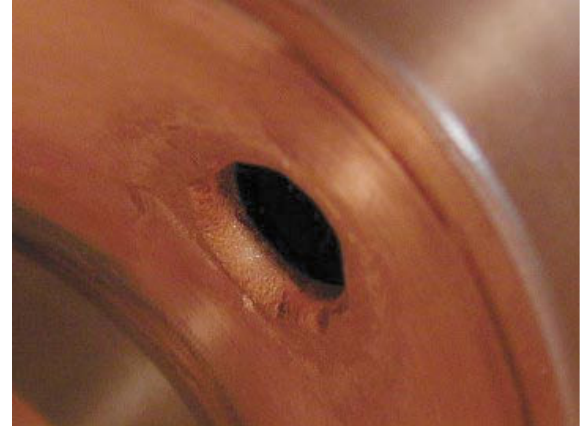
FIG. 22. (Color) A picture of the high-power coupling aperture of cavity 1 after the first high-power test. The aperture has been rounded in the direction of the magnetic field. The electric field has caused pitting to occur on either side of the aperture at right angles to the